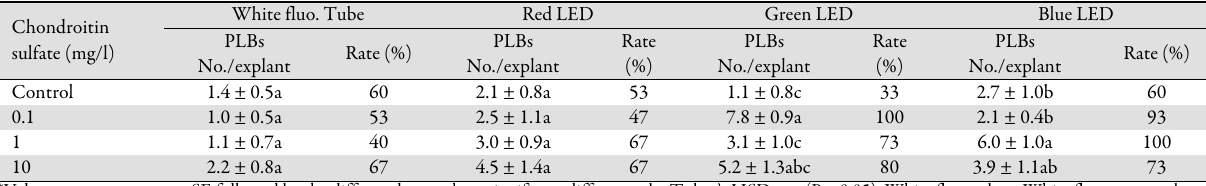
Table 1. In vitro growth of C. dayanum PLBs into different concentrations of chondroitin sulfate with modified MS medium, under four sources of lights White fluo. Tube Red LED Chondroitin PLBs sulfate (mg/l)